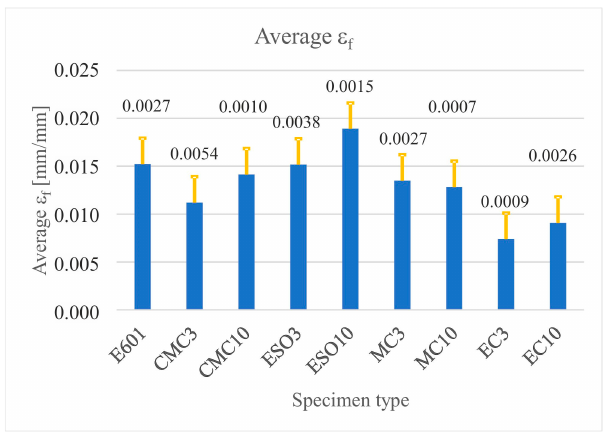
Figure 10. Average values of failure strain with standard deviation bars as a function of the specimen type.